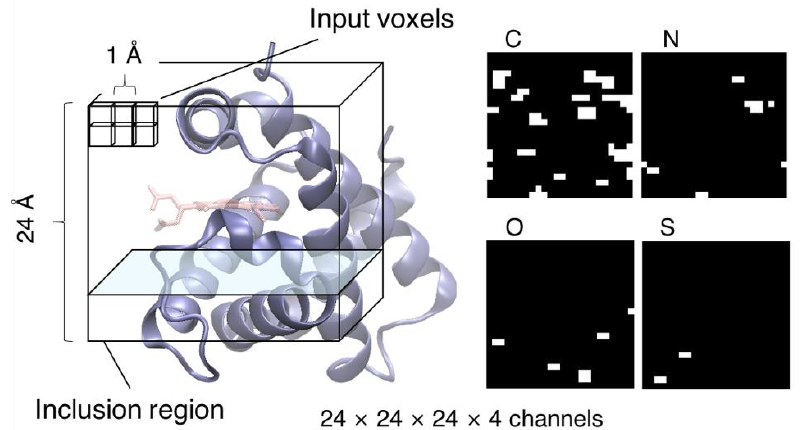
Figure 2. Schematic of the input of our CNN model. The protein backbone and heme molecule are represented as a blue cartoon and a licorice model colored in salmon, respectively. The input voxels were prepared for each atom of C, N, O, and S, as illustrated in the right panel. The coordinates of heme and molecules other than protein were not used in the voxel calculation. Table 1. Layers and parameters of our CNN model.